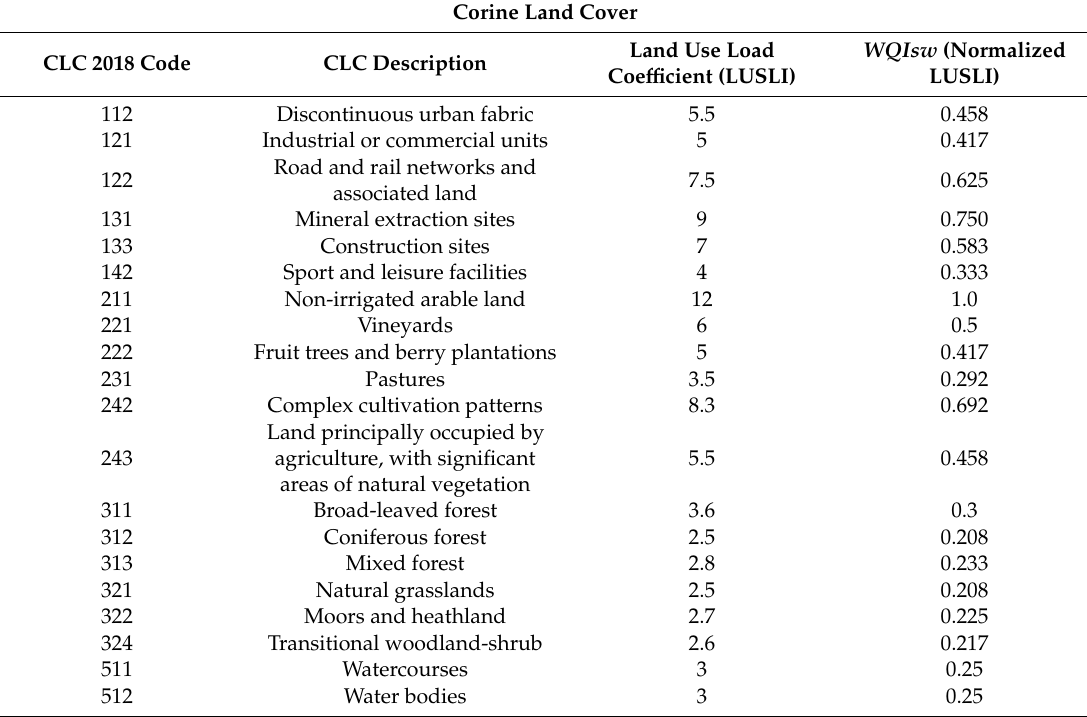
Table 1. Land use load coe ffi cient (LUSLI) applied for Corine land cover 2018 categories in the Kupa River catchment